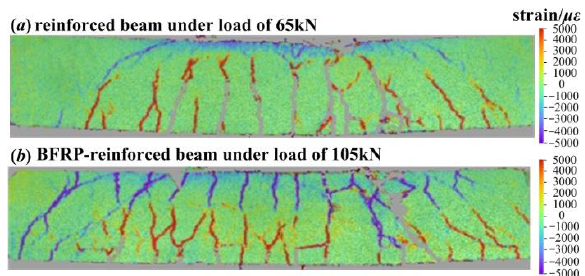
Figure 15. Comparison of crack propagations on ( a ) reinforced coral aggregate concrete beam under load of 65 kN and ( b ) BFRP-reinforced coral aggregate concrete beam under load of 105 kN.